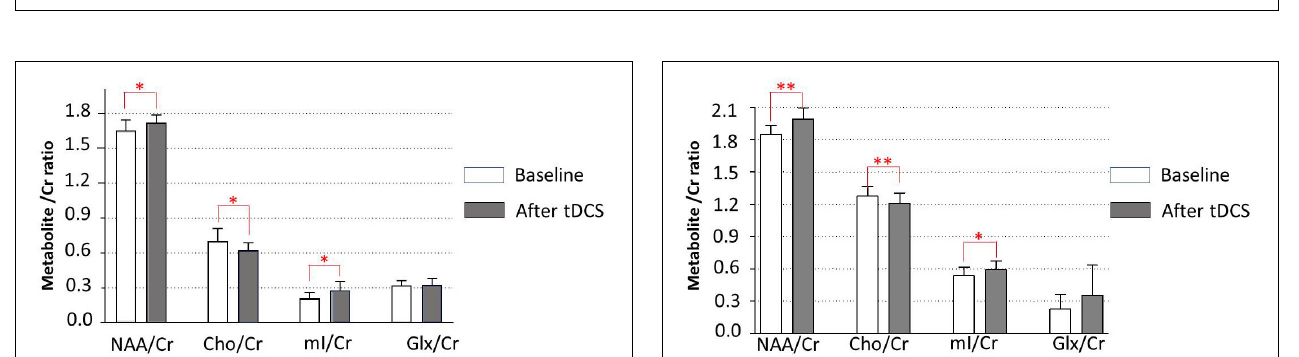
FIGURE 2 | The voxels were placed at (A) left DLPFC, (B) right DLPFC, (C) right ACC, (D) left ACC, (E) right amygdala, (F) left amygdala, and (G) locus coeruleus. The yellow box indicates the location of a single voxel in the areas of interest. Abbreviations: A, anterior; F, feet; H, head; L, left; P, posterior; R, right.